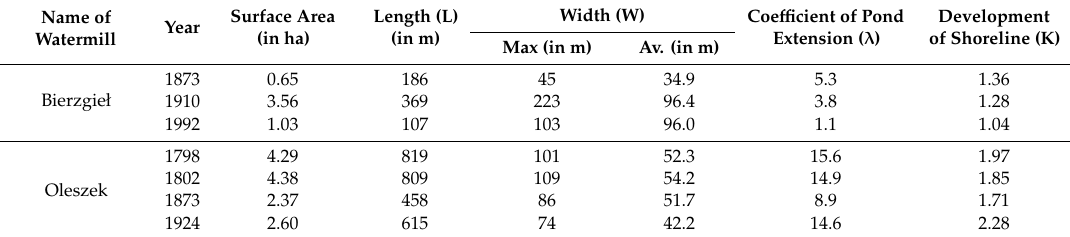
Table 3. Changes in selected morphometric features of mill ponds at the turn of the 19th and 20th